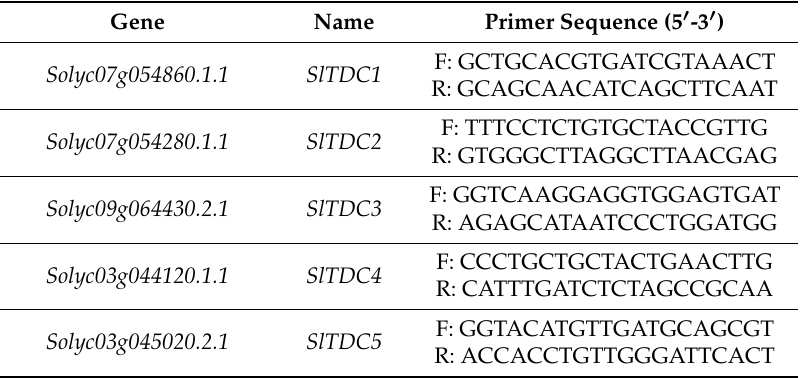
Table 3. Primers of TrpCD genes in tomato.